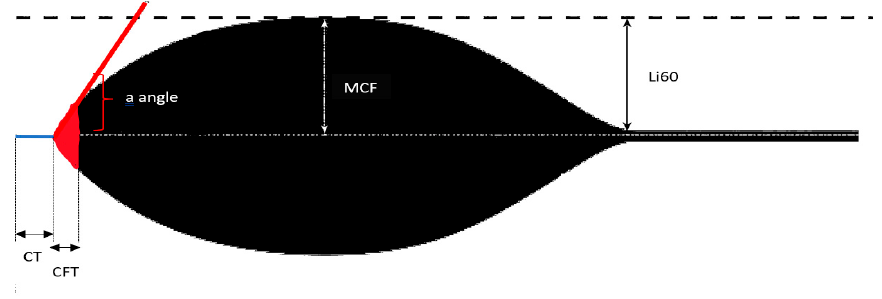
Figure 3. Graphical illustration of a normal Rotem trace.